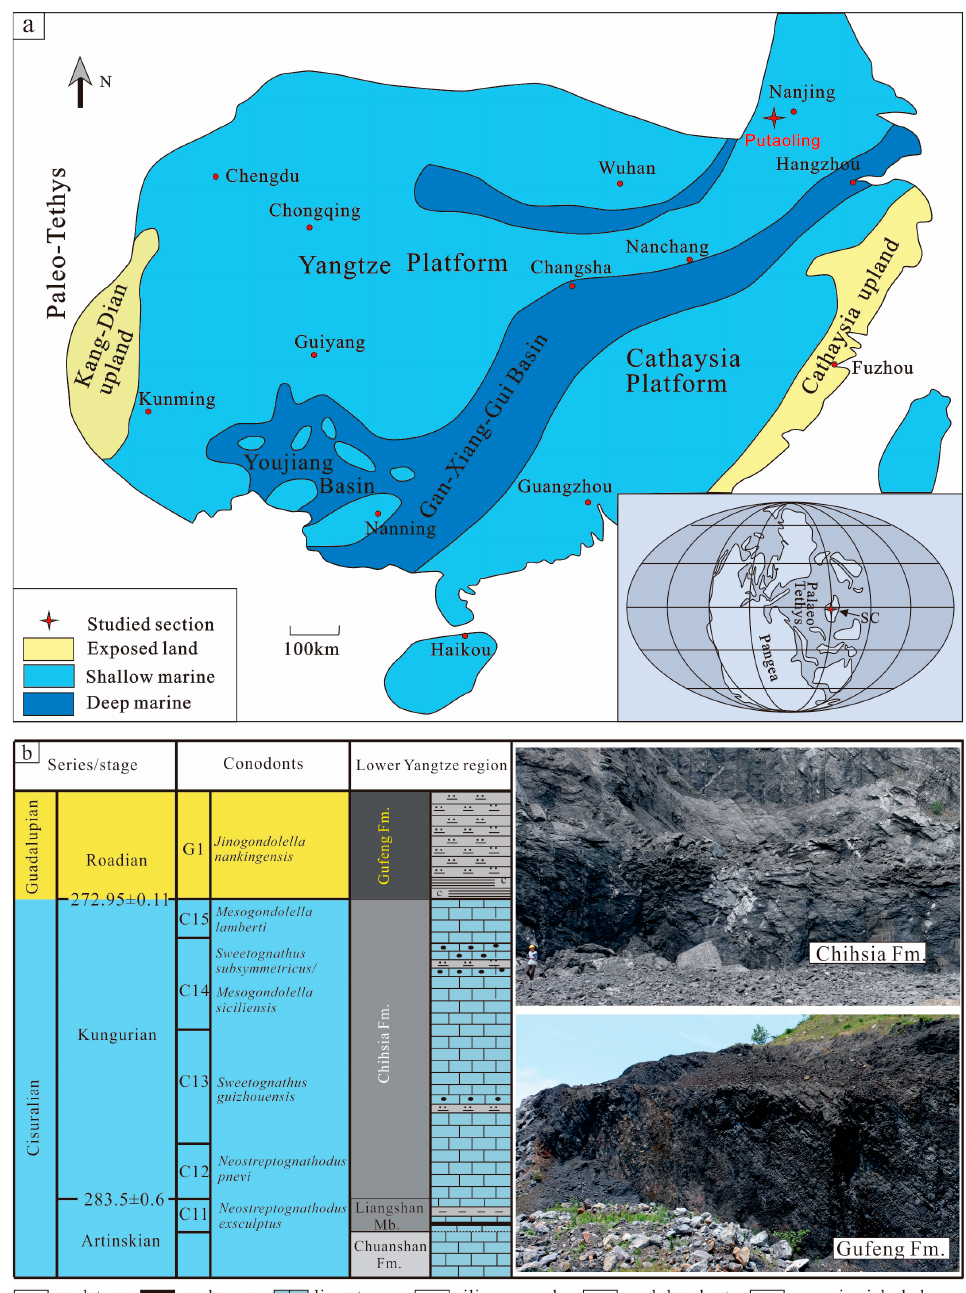
Figure 1. ( a ) Lithofacies palaeogeography during the Kungurian Stage in South China and the location of the studied section (modified from [29]). The inset box shows the global palaeogeography of the early–middle Permian transition. Note the location of the South China block (SC; arrowed) and the studied section (star). ( b ) A stratigraphic framework for the early Permian strata from the Lower Yangtze region (modified from [28]), the general outcrop characteristics of the Chihsia and Gufeng Formations.